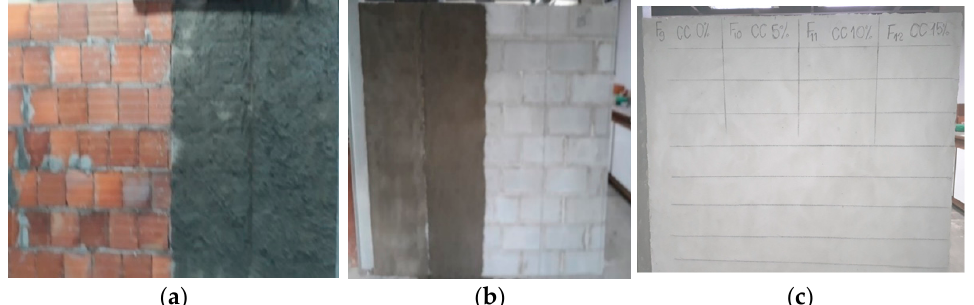
Figure 3. ( a ) Wall of ceramic bricks; ( b ) wall of concrete blocks, all with roughcast applied; and ( c ) wall of ceramic bricks with roughcast and mortar coating applied. ( c ) wall of ceramic bricks with roughcast and mortar coating applied.